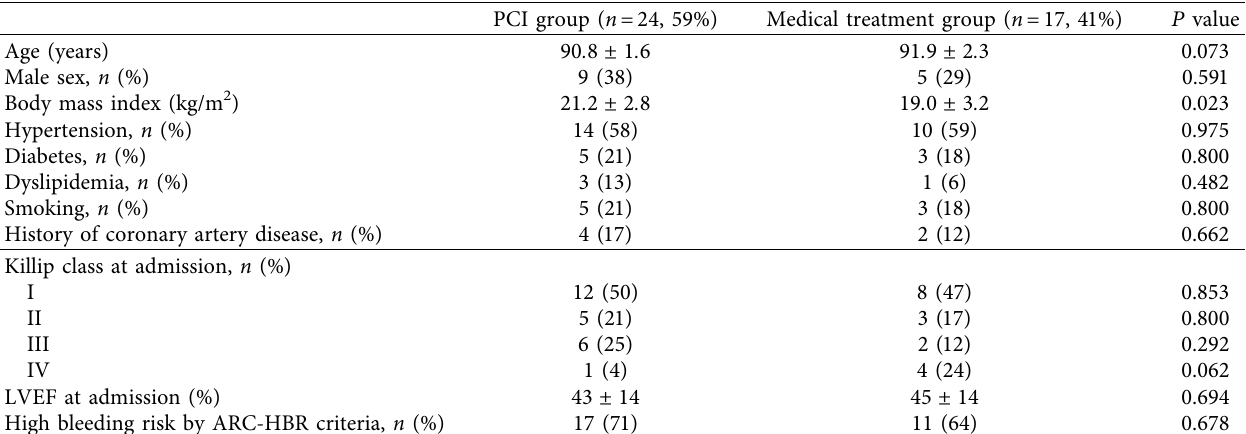
Table 1: Baseline demographic and clinical